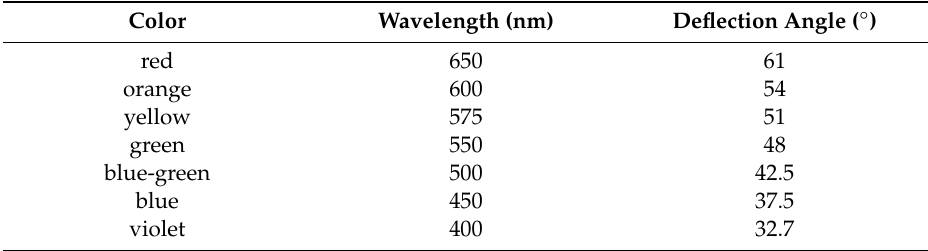
Table 2. Incident angle in the diffraction grating for obtaining different colors.